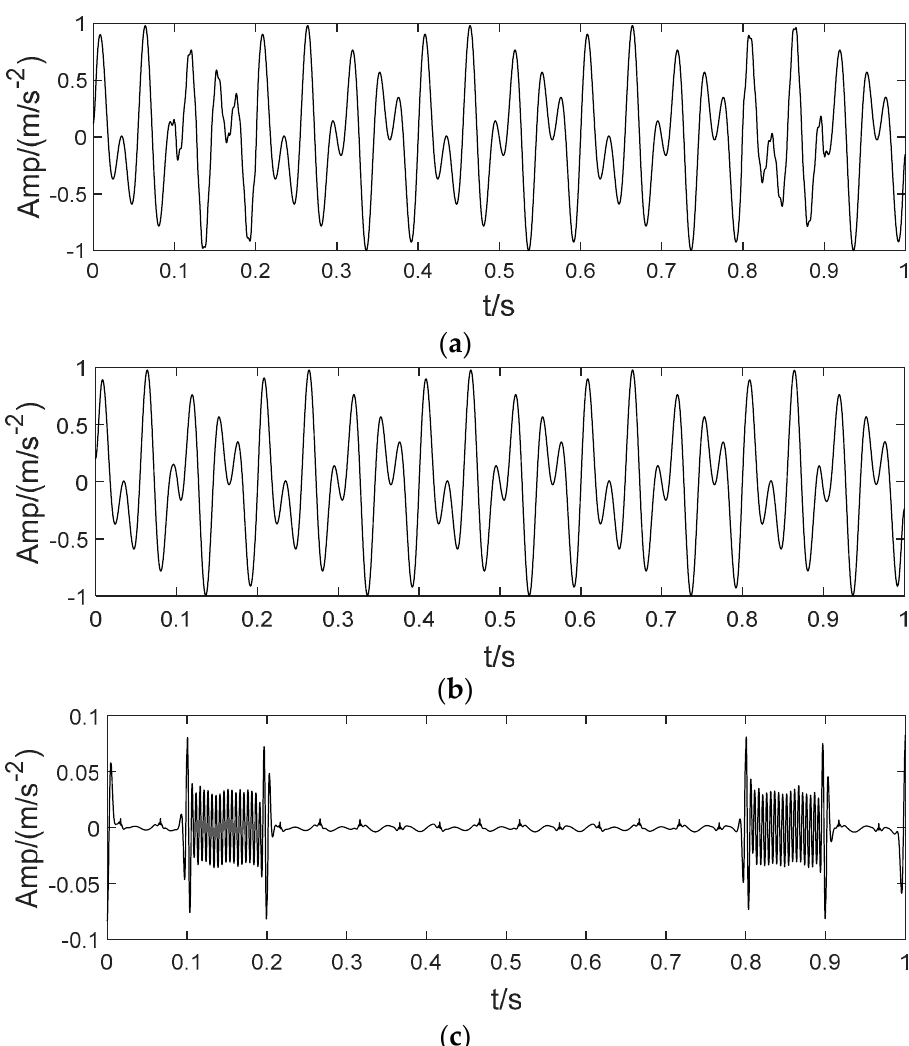
Figure 8. The Third decomposition of IMF11. ( a ) IMF11, ( b ) The IMF111 obtained by decomposition and ( c ) IMF112.